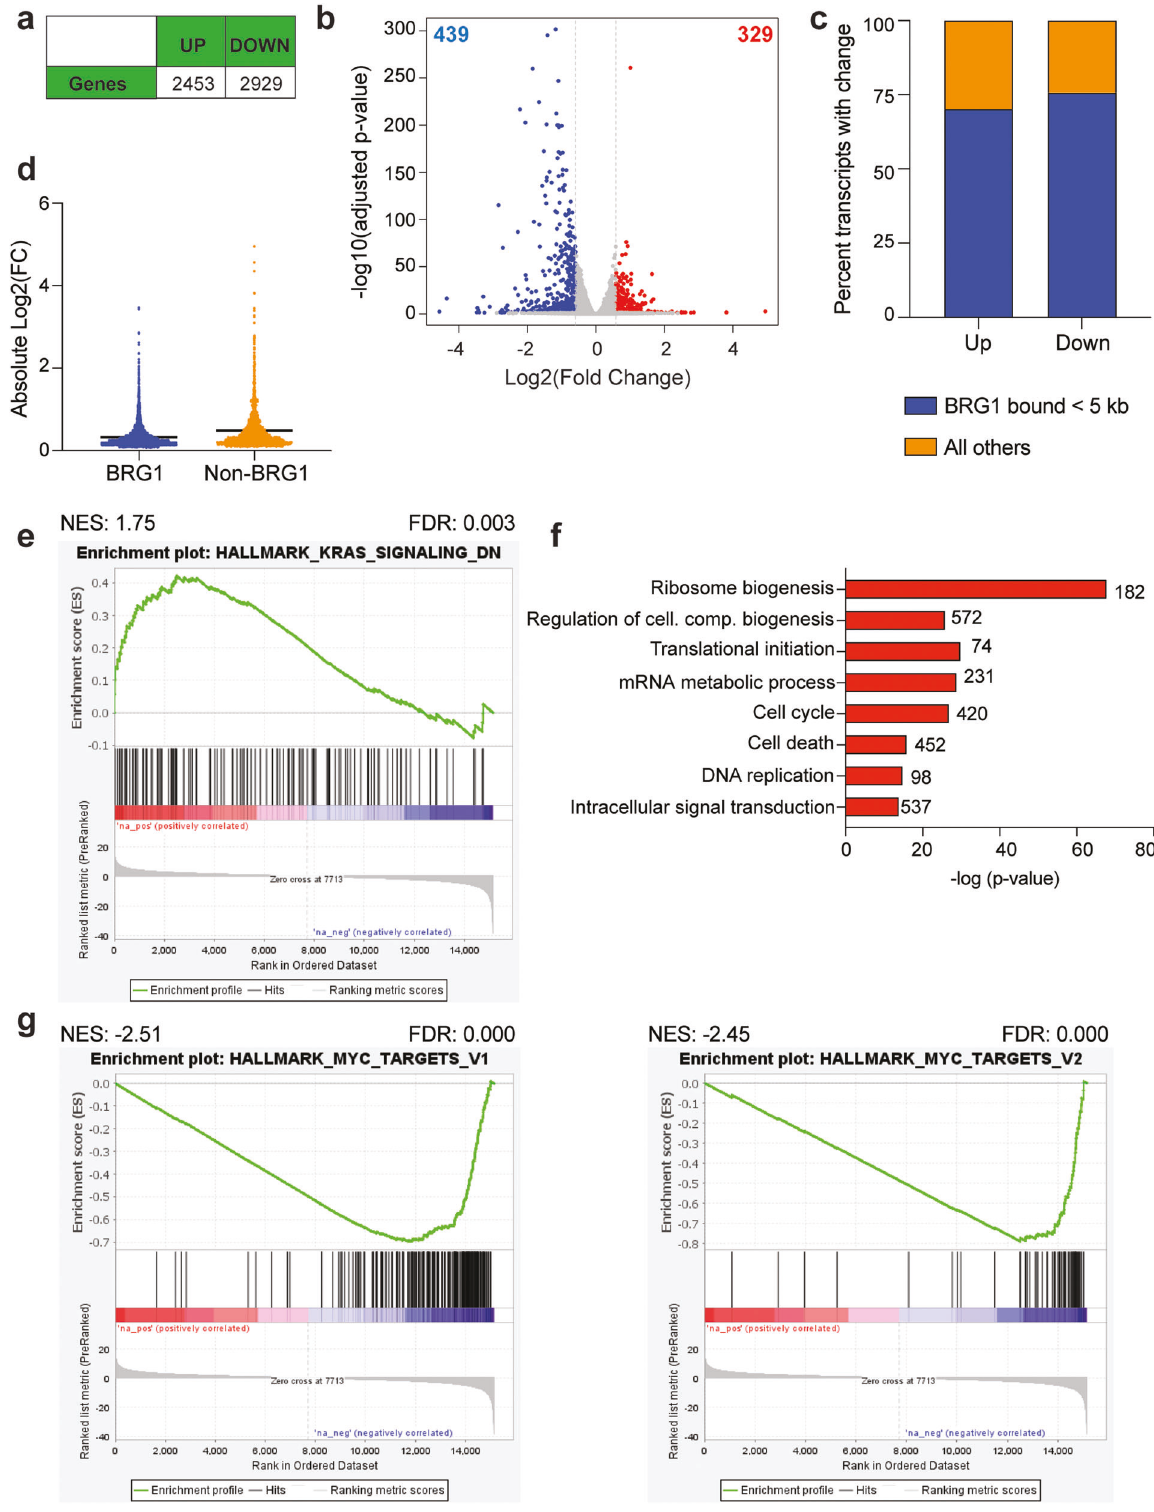
MRT, each results in distinct changes to the transcriptome as well. GO analysis of these commonly downregulated genes highlights ribosome biogenesis as the top enriched biological process, along with nucleolar genes, ribosome protein